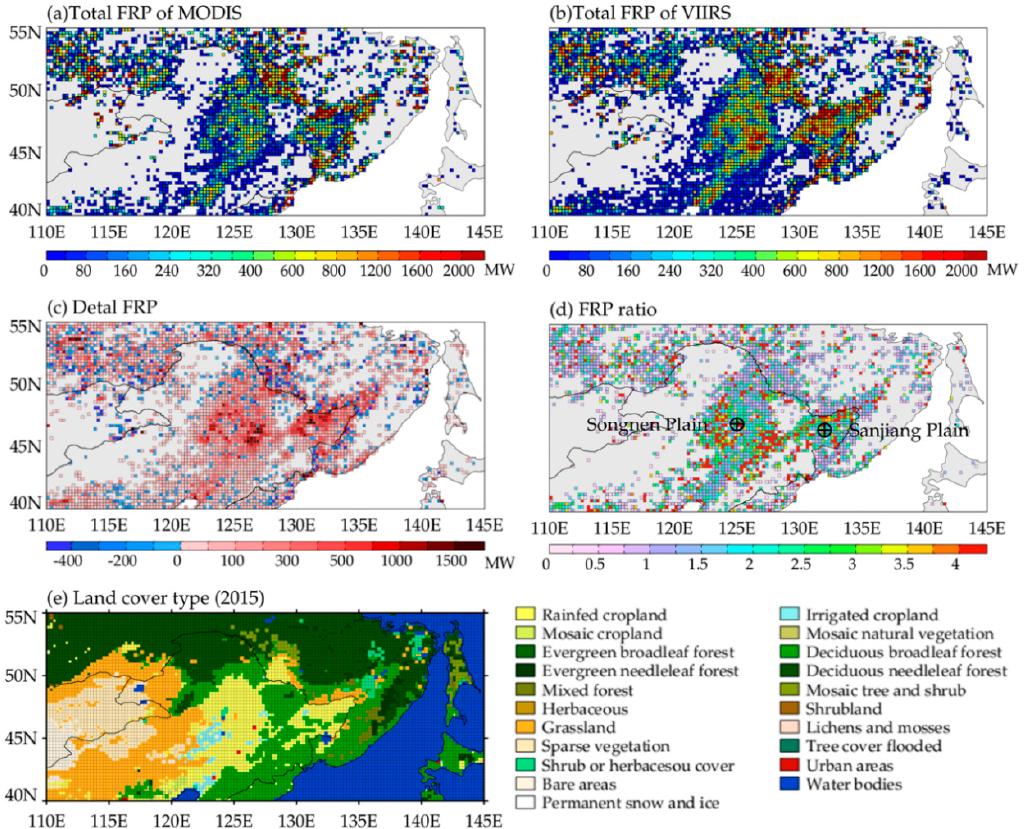
Figure 7. Spatial distribution of total FRP over 2012–2017 in Northeast Asia at 0.25° resolution: ( a ) MODIS; ( b ) VIIRS; ( c ) Delta FRP (VIIRS minus MODIS); ( d ) VIIRS-to-MODIS FRP ratio; ( e ) land cover type shown in 2015.